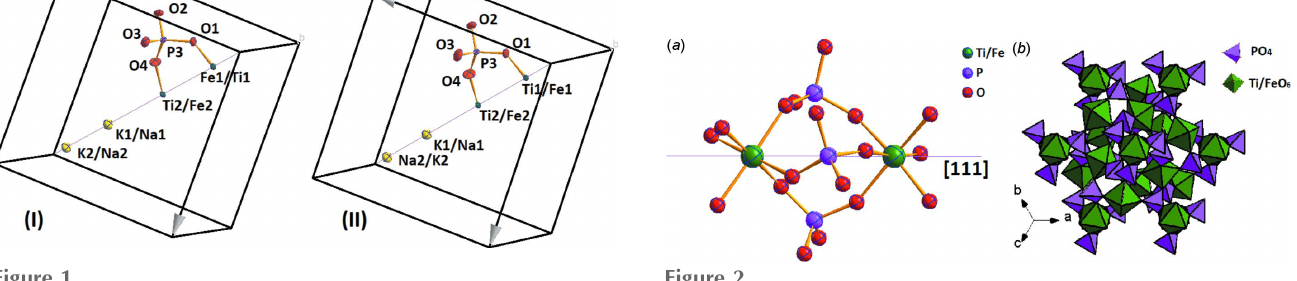
Figure 1 A view of the asymmetric units of (I) and (II), with displacement ellipsoids drawn at the 50% probability level.